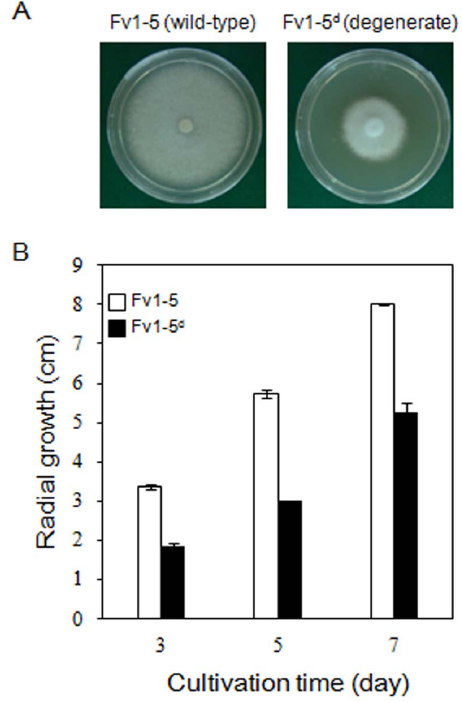
Figure 1. Mycelial growth of wild-type and degenerate dikaryons of F. velutipes . (A) Morphology of the mycelia of the wild-type (left) and degenerate strains (right) that were grown on MCM agar for 7 d. (B) Growth rates of the wild-type and degenerate strains were determined based on the diameter of the mycelia grown at 25 u C. The error bars represent the mean standard deviations of triplicate samples.